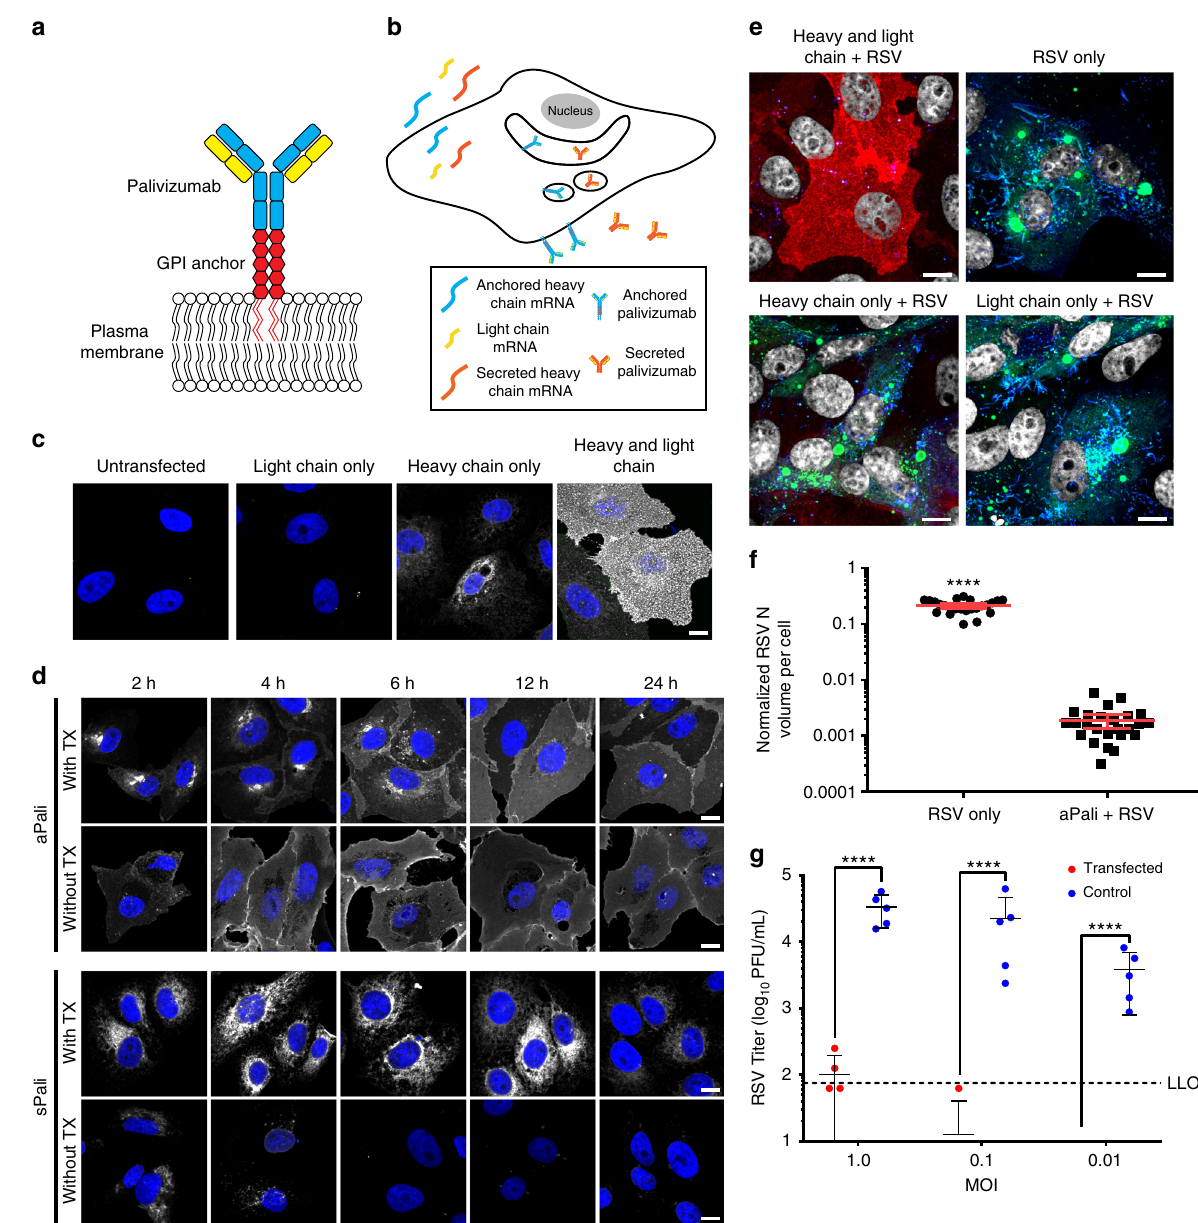
Fig. 1 aPali is anchored to the membrane and inhibits RSV in cells. a Schematic of aPali anchored to the plasma membrane. b Schematic of aPali and sPali mRNA delivery and expression. c Cells were transfected with vehicle control or 1 μ g of either aPali heavy chain only, aPali light chain, or both the heavy and light chain mRNAs. 24 h later, cells were fi xed, permeabilized, and stained with a donkey anti-human secondary antibody (white). Scale bar represents 10 μ m. d Cells were transfected with 1 μ g of either aPali or sPali mRNA. At 2, 4, 6, 12, and 24 h, cells were fi xed, permeabilized or not, and stained for the expressed antibody (white). Scale bar represents 10 μ m. e Cells were transfected with vehicle control or 1 μ g of either aPali heavy chain only, aPali light chain only, or both the heavy and light chain mRNAs. After overnight incubation, cells were infected for 24 h before being fi xed and stained for RSV N (green), panRSV (blue), and aPali (red). Scale bar represents 10 μ m. f Quanti fi cation of the mean volume of the RSV N signal per cell from microscopy images in part ( e ). Error bars represent 95% con fi dence intervals. Asterisks indicate p < 0.0001 (Mann – Whitney U test). 25 cells were analyzed per group. Results represent mean of two independent experiments. g Cells were transfected with vehicle control or 1 μ g of aPali and infected with RSV at MOI of 0.01, 0.1, and 1. Supernatants were collected at 24 hpi and virion titers were measured by plaque assay. Each data point represents mean of 4 replicate wells. Error bars represent standard deviation. Dotted line represents lower limit of detection. Asterisks indicate p < 0.0001 (one-way ANOVA of log- transformed data). Results represent mean of three independent